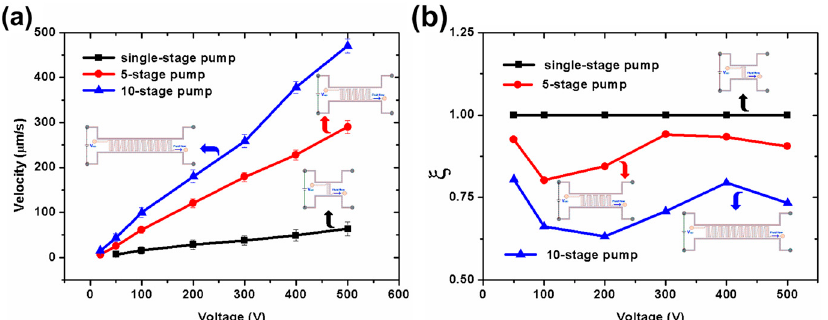
Figure 5. Experimental results of pumping velocity vs. pump stage number. ( a ) Pumping velocity as a function of driving voltage with different pump stage number; ( b ) Pumping efficiency ξ as a function of driving voltage with different pump stage number. The PDMS gap is 20 µ m. The pumping channels are 200 µ m long, 20 µ m wide. The connecting channels are 280 µ m long, 20 µ m wide. The inlet and outlet channels are 2 mm long, 40 µ m wide. All channels are 20 µ m high.